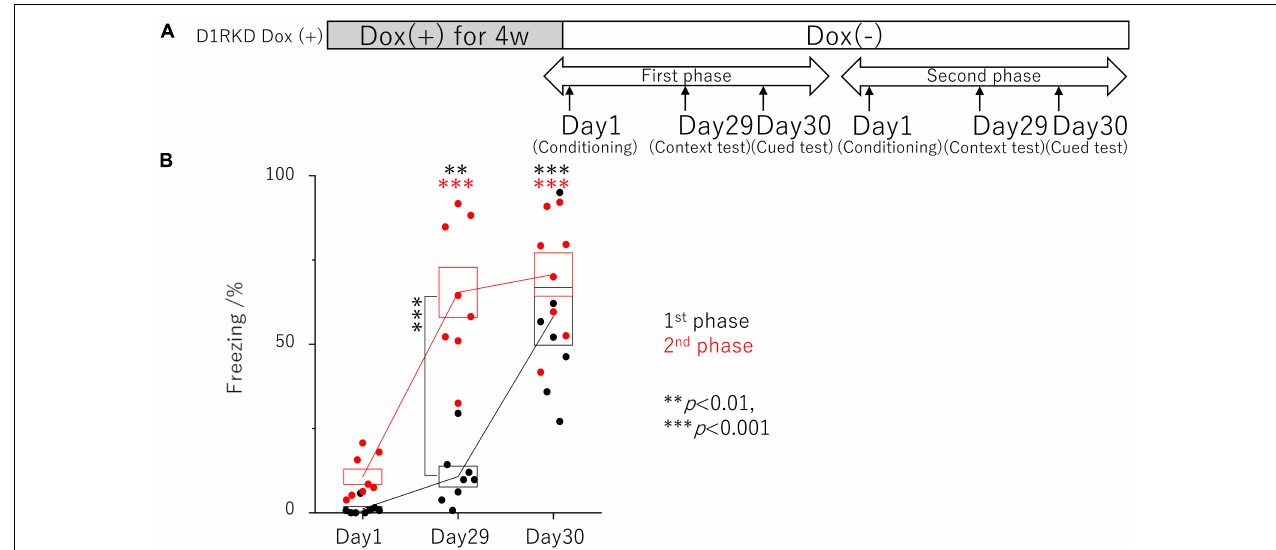
FIGURE 2 | Contextual and auditory cued fear conditioning test with the same mice for remote phase. (A) Experimental schedule. Experiments were conducted only in the D1RKD Dox (+) group ( n = 8) and the experiments of the 1st phase and 2nd phase were performed with the same mice. Dox (2 mg/mL) was administered for 4 weeks prior to the commencement of the experiment and until after the completion of conditioning as the learning session on Day 1, with mice provided drinking water without Dox thereafter. Conditioning on Day 1, contextual test on Day 29, and auditory cued test on Day 30 conducted for 1st phase and 2nd phase tests, respectively. (B) In 1st phase and 2nd phase, the freezing time of mice was recorded during the contextual tests of Day 29, and the auditory cued tests of Day 30 as the test session with the same mice, respectively. The black circles indicate the values in 1st phase, and the red circles indicate the values in 2nd phase, ∗∗ p < 0.01; ∗∗∗ p <